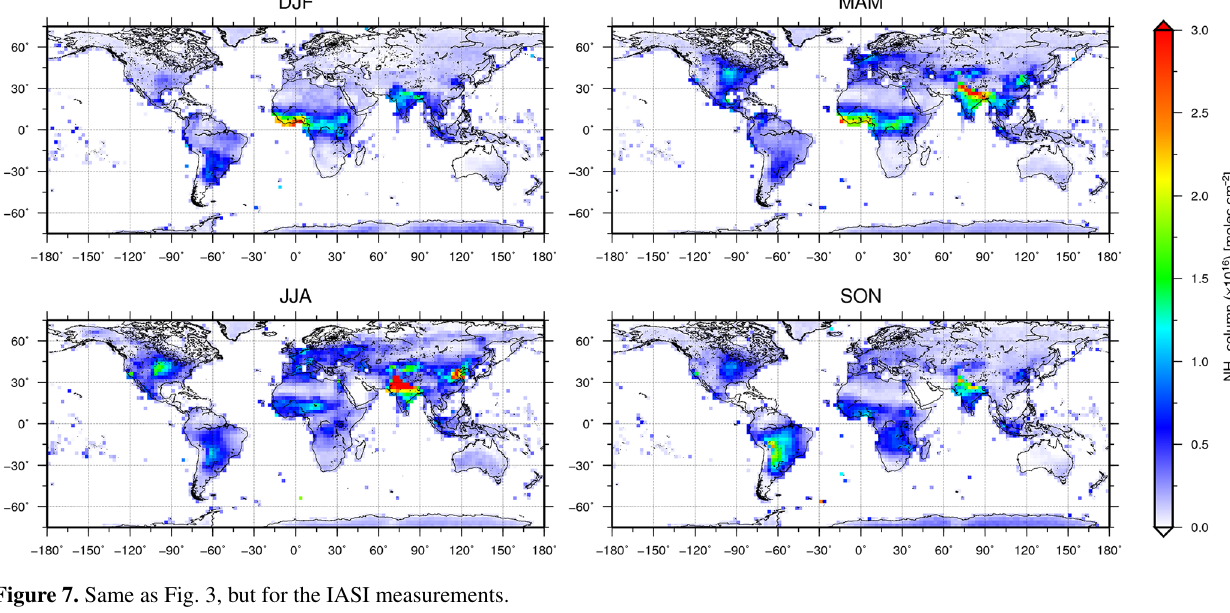
Figure 7. Same as Fig. 3, but for the IASI measurements.